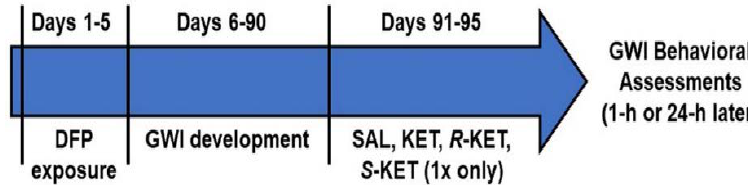
Figure 1. Experimental Design Nine-week old male Sprague-Dawley rats were exposed once-daily to organophosphates (OP) agent DFP (0.5 mg/kg, s.c.) or vehicle (ice-cold PBS). About three-months later, diisopropyl fluorophosphate (DFP) rats were treated with saline (SAL) or various doses of either ketamine (KET) or its enantiomers: R -ketamine ( R -KET) or S -ketamine ( S -KET) and assessed for behavioral effects at 1 or 24 h post-injection.